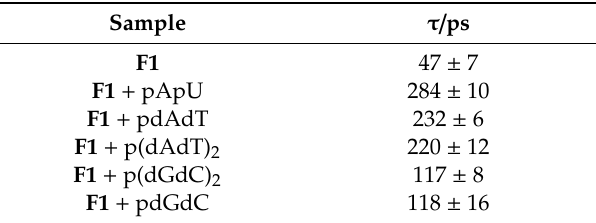
Table 1. Measured fluorescence lifetimes for flavylium F1 ( c = 1 × 10 − 5 mol · dm − 3 ) upon the addition of